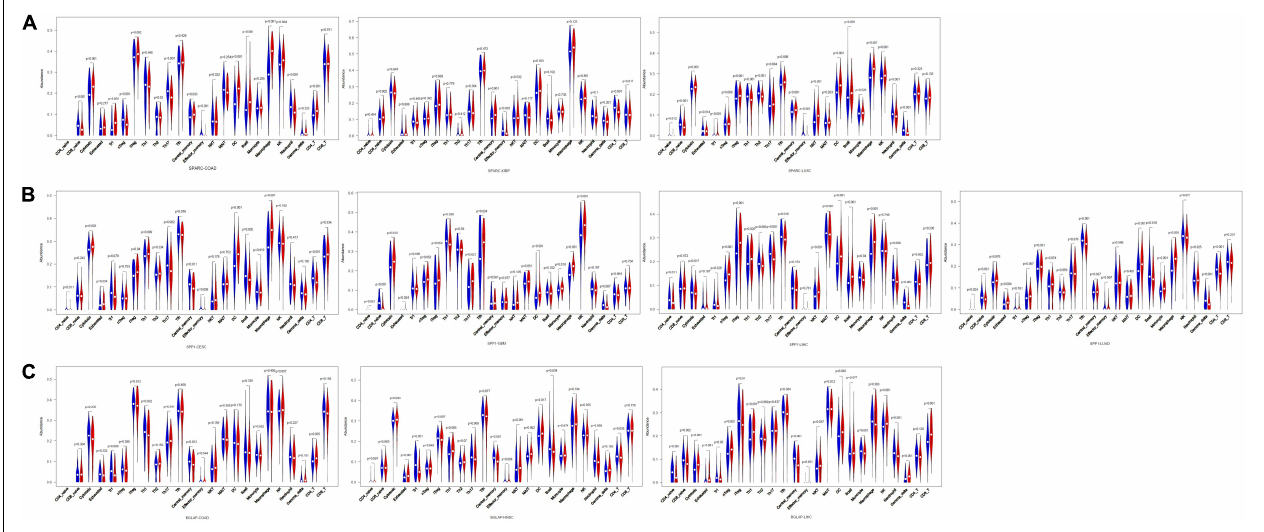
FIGURE 8 | Violin plots of comparison of immune cell infiltration between high and low subgroups in the cancer types in which osteomimicry indicated unfavorable survival. Results from ImmuCellAI indicated that the high expression subgroups of SPARC (A) , SPP1 (B) , and BGLAP (C) had significant more DCs infiltration in the majority of study models. p < 0.05 represents that difference is statistically